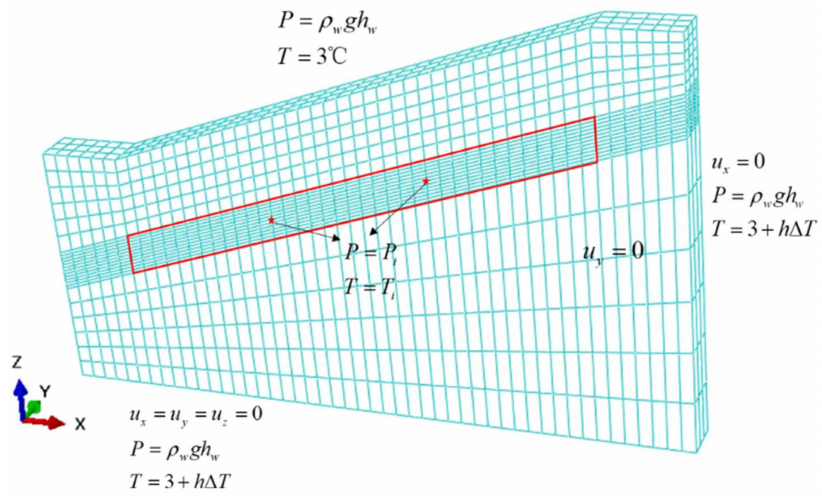
Figure 2. Mesh generation and boundary